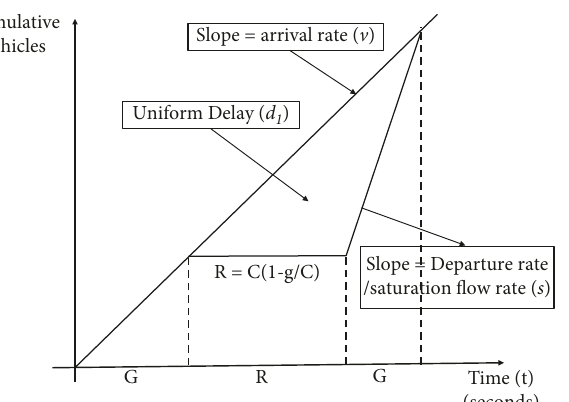
Figure 5: Components of delay-random delay.